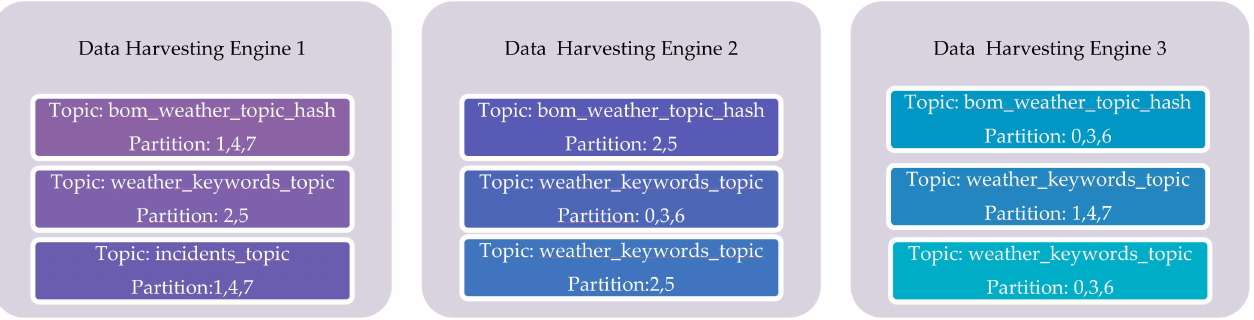
Figure 4. Providing Fault Tolerance using brokers, topics,